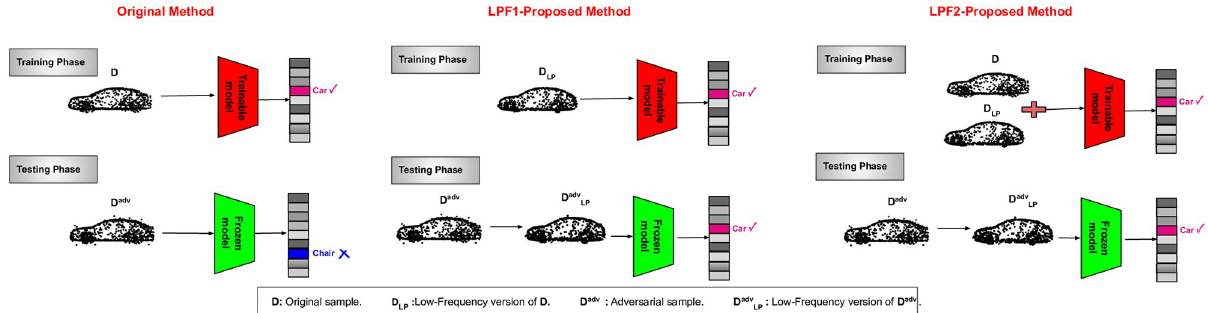
Fig 2. An overview of proposed (LPF1 and LPF2) defense methods versus original method. Original method fails in robustness against adversarial attacks at test time. Proposed defense methods have overcome this issue.